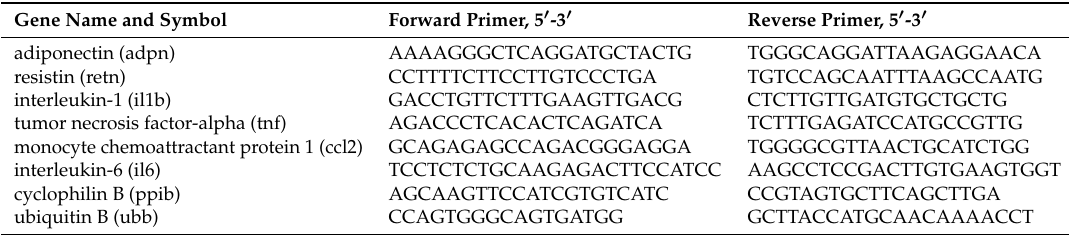
Table 1. Primer sequences for genes analyzed by